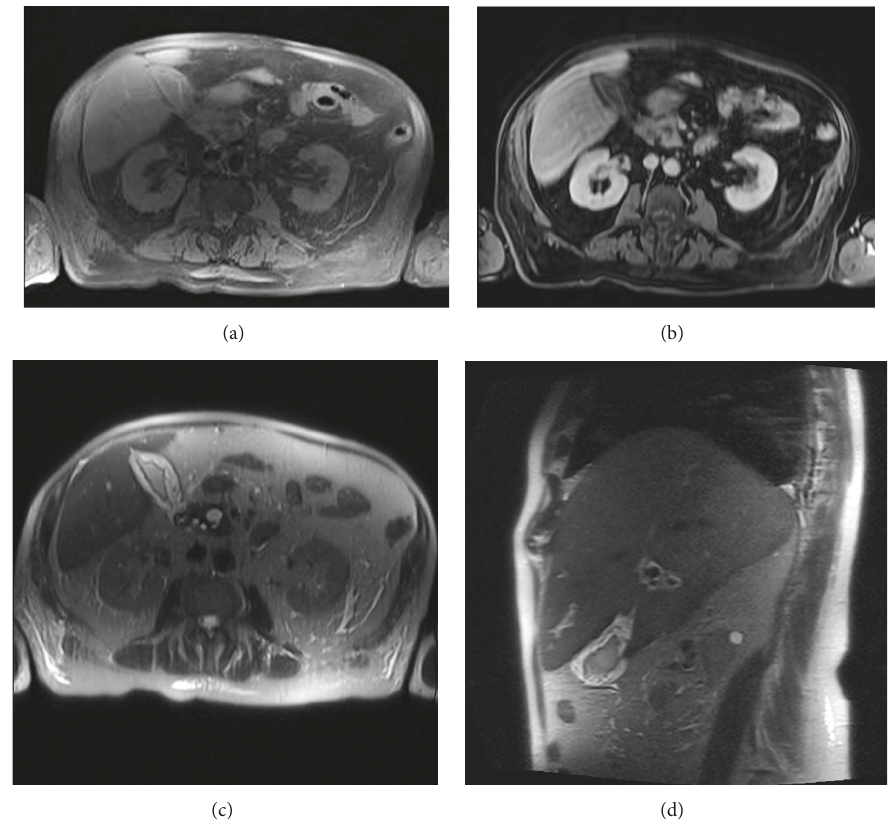
Figure 4: (a) Axial T1W-VIBE precontrast, (b) axial T1W-VIBE postcontrast, (c) axial T2W-fat suppressed, and (d) coronal T2W-fat suppressed sequences. MR images show diffuse gallbladder wall thickening with increased signal intensity on T2 weighted fat suppressed images. Postcontrast fat suppressed images demonstrate homogeneous mucosal enhancement with no transmural wall